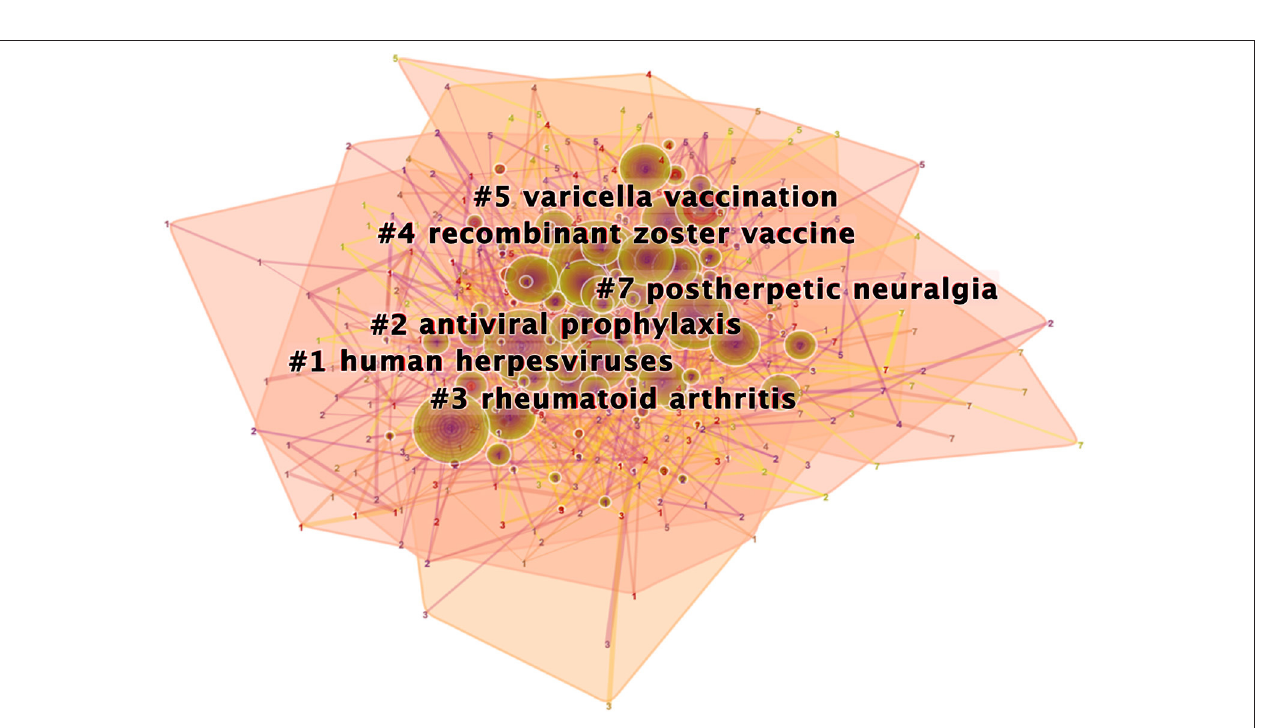
FIGURE 6 | The clustered network map of keywords on herpes